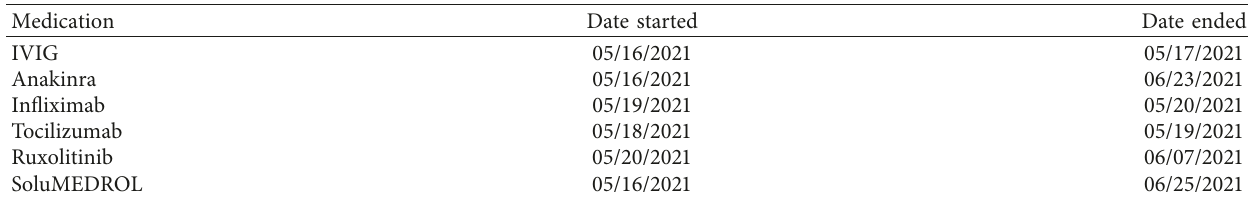
Table 2: Timeline and duration of anti-inflammatory drugs.